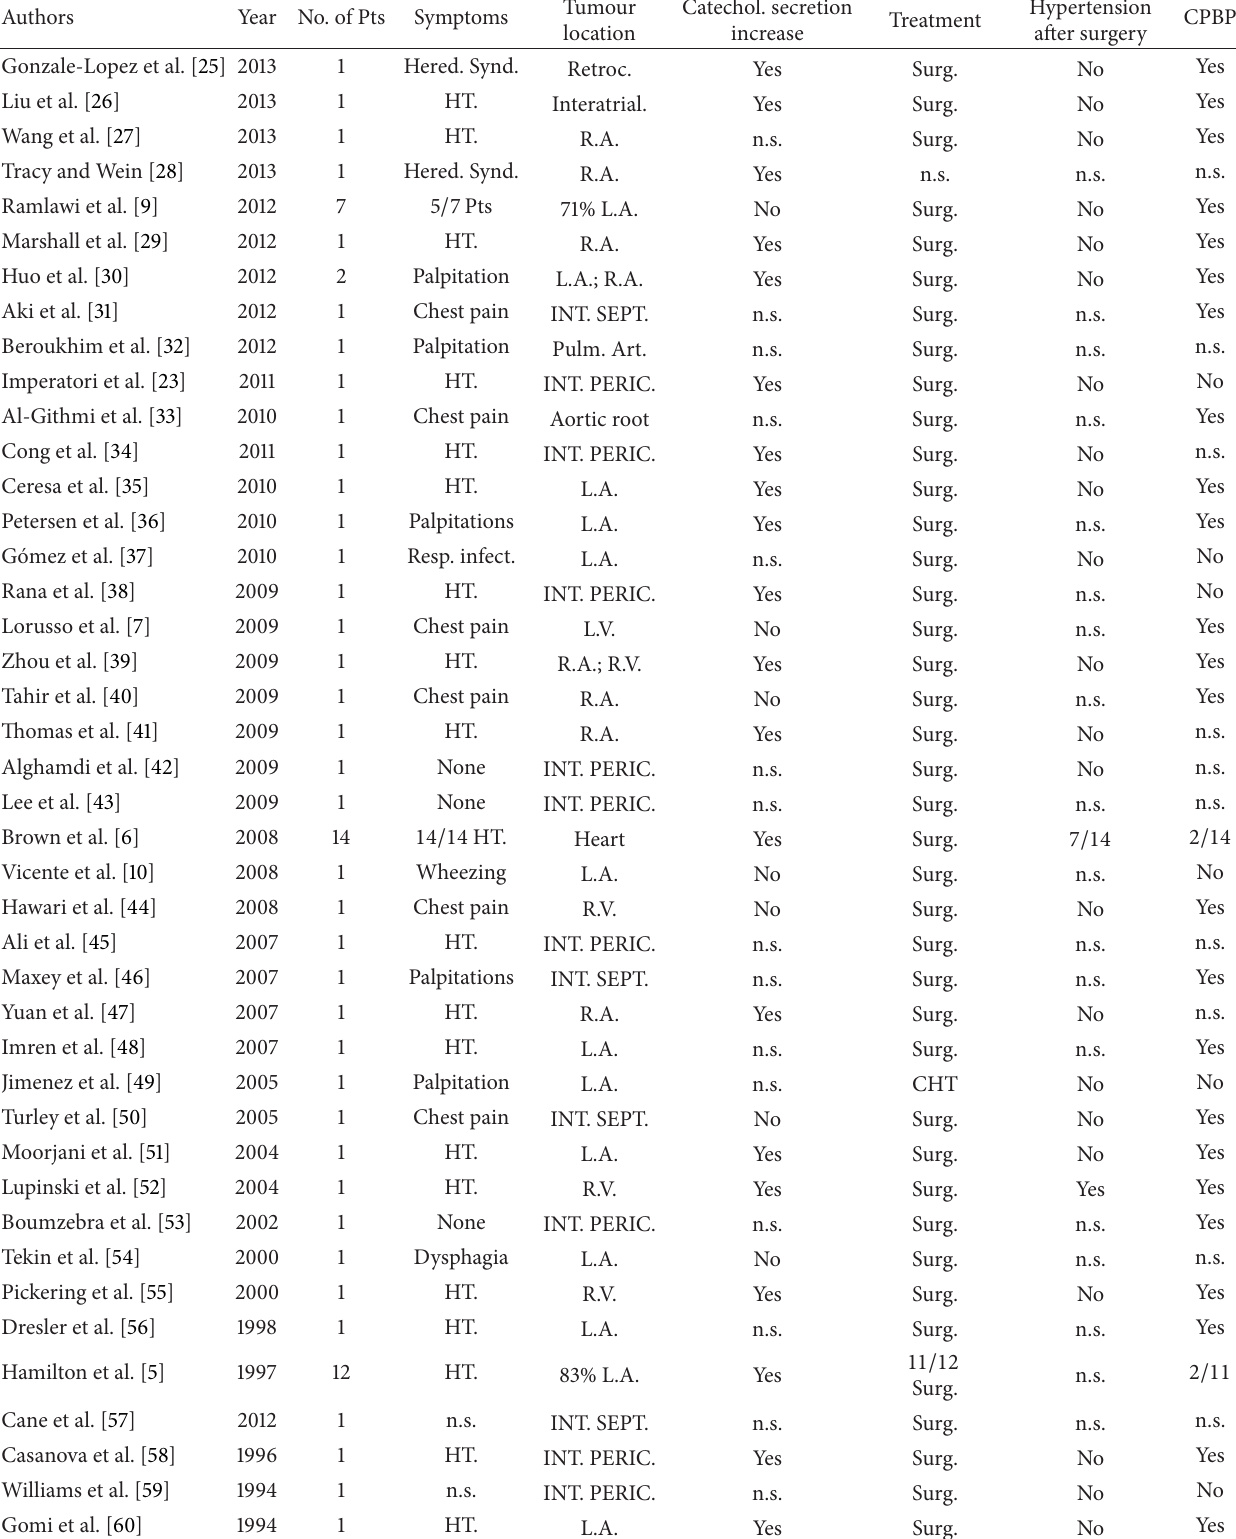
Table 1: Published case reports of intrapericardial paraganglioma in